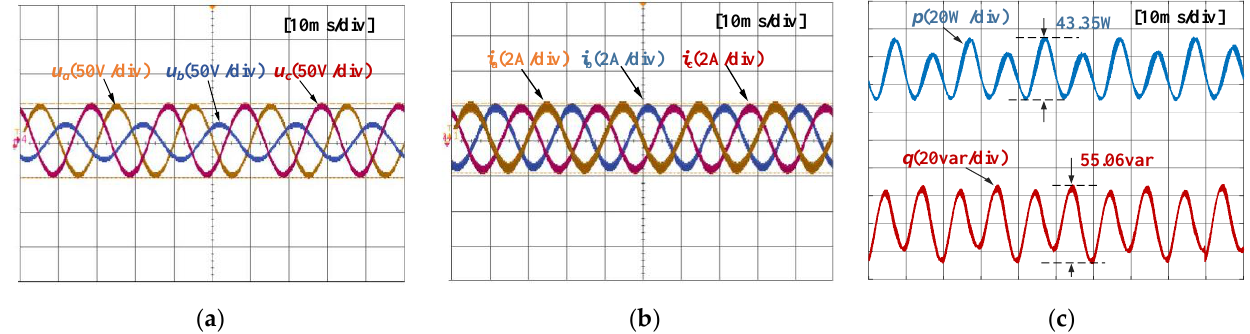
Figure 14. Experimental results of the traditional topology, when V b drops to 0.5 p.u. ( a ) Output voltage at PCC 1 ; ( b ) output current; ( c ) output active power and reactive power.